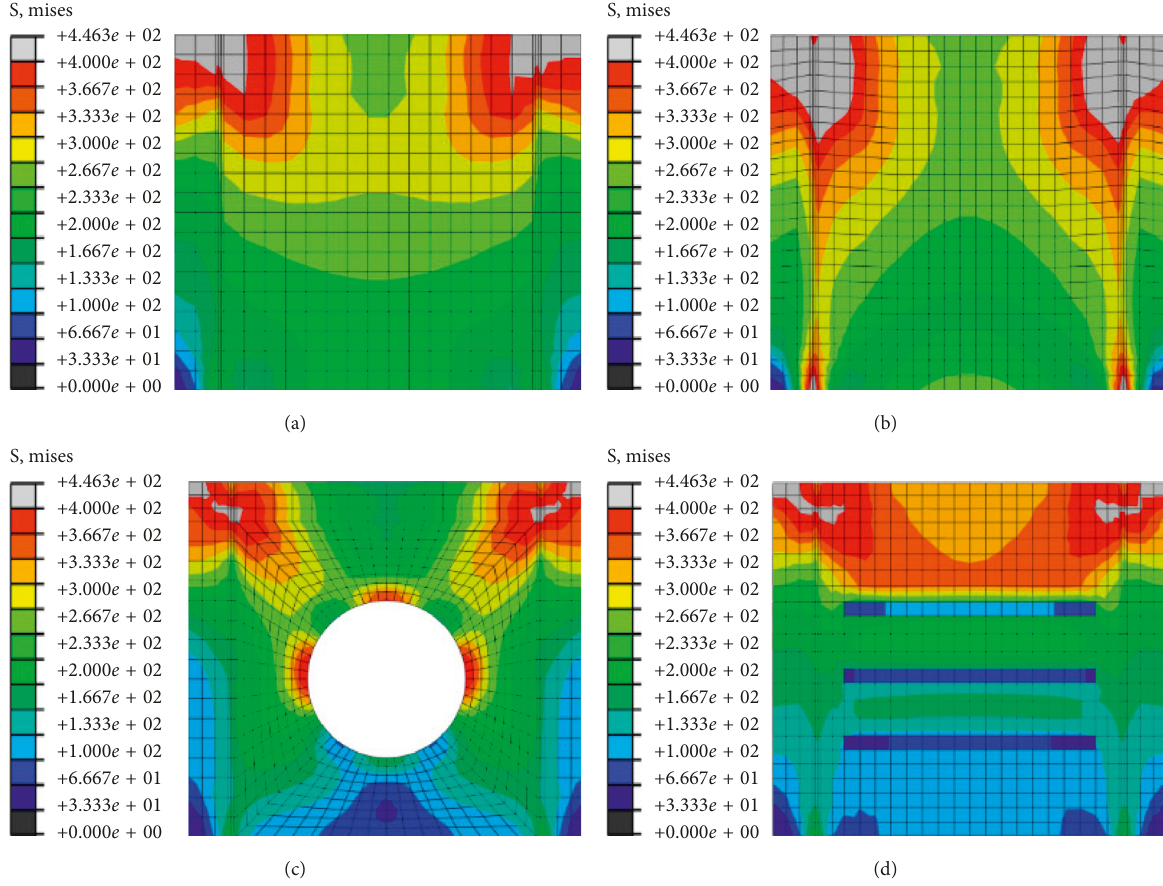
Figure 12: Stress analysis of the plate: (a) SJ-1, (b) SJ-2, (c) SJ-3, (d)